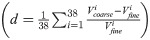
Comparison between the two refinements for all hemodynamic indicators.(A) Correlation plot between coarse and fine refinements. (B) Logarithmic Bland-Altman plot of coarse versus fine (Vcoarse
vs Vfine). r denotes the Pearson correlation coefficient, d the average difference (d=138∑i=138Vcoarsei−VfineiVfinei). All values are normalized with the max value at the finest refinement. The red circles refer to the cases displayed in Fig 4. *: In 5 cases, LSA was zero for at least one of the two refinements (and less than 0.03 on the other). These are excluded from the Bland-Altman plot and the computation of d, to avoid division-by-zero.